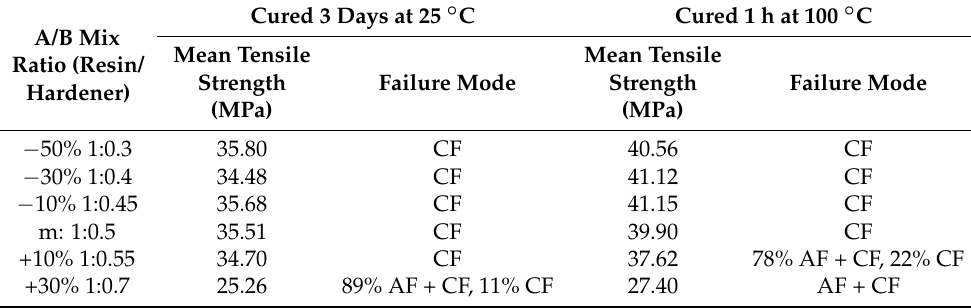
Table 3. Failure mode change after heat curing samples tested at 25 ◦ C.